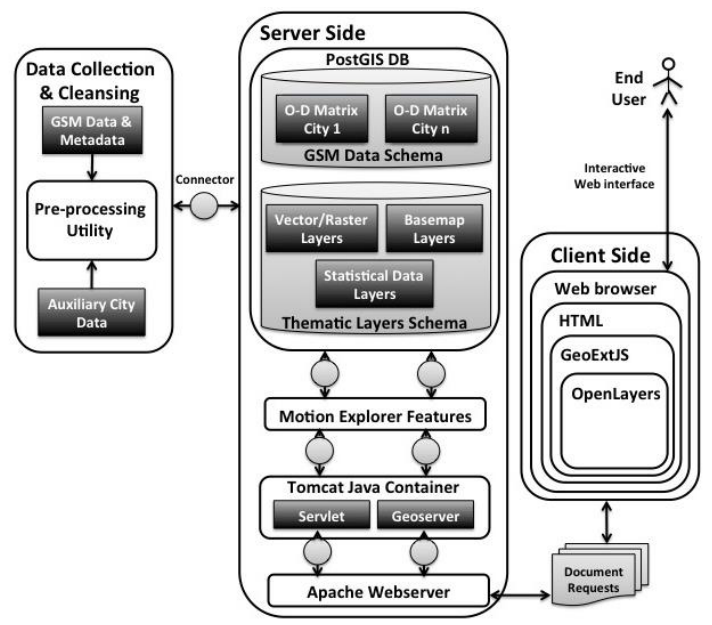
Figure 3. System architecture of the Mobility Explorer.